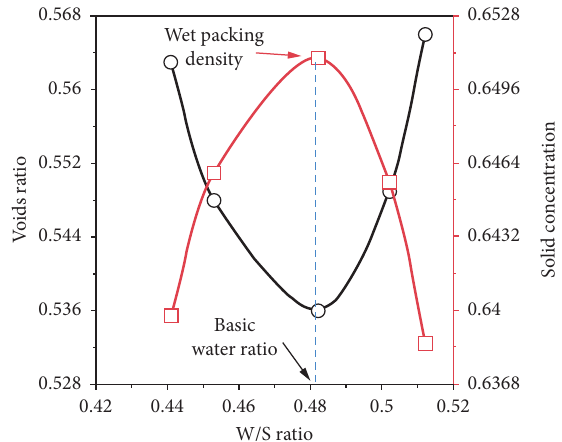
Figure 2: Wet packing test results for tailings.